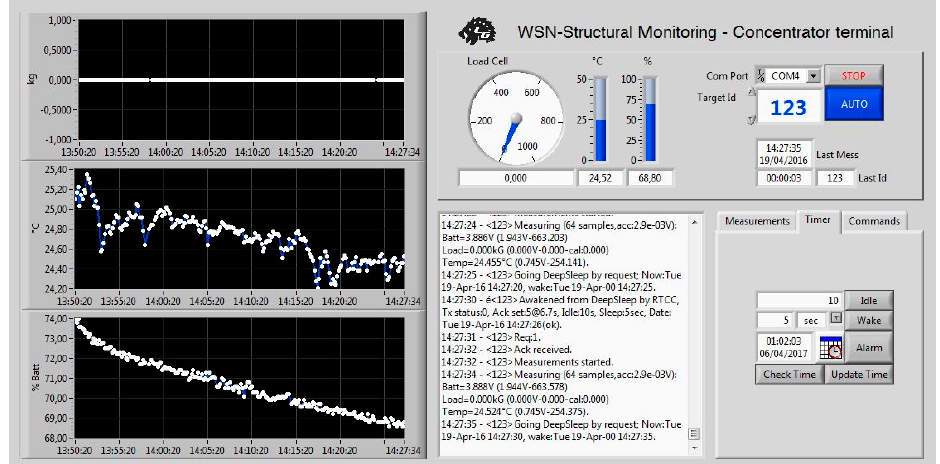
Figure 20. Short-term monitoring analysis.